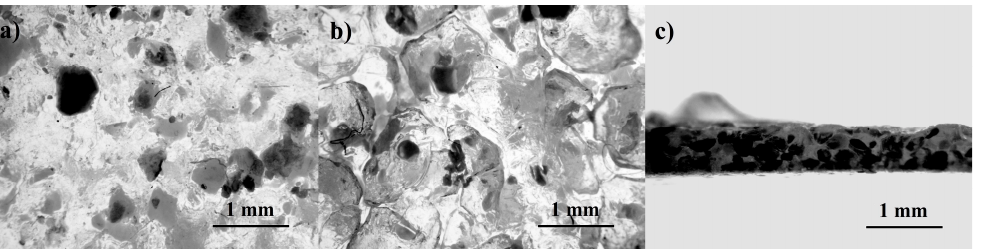
Figure 5. Graph of caffeine content and coefficient of caffeine release of the samples.